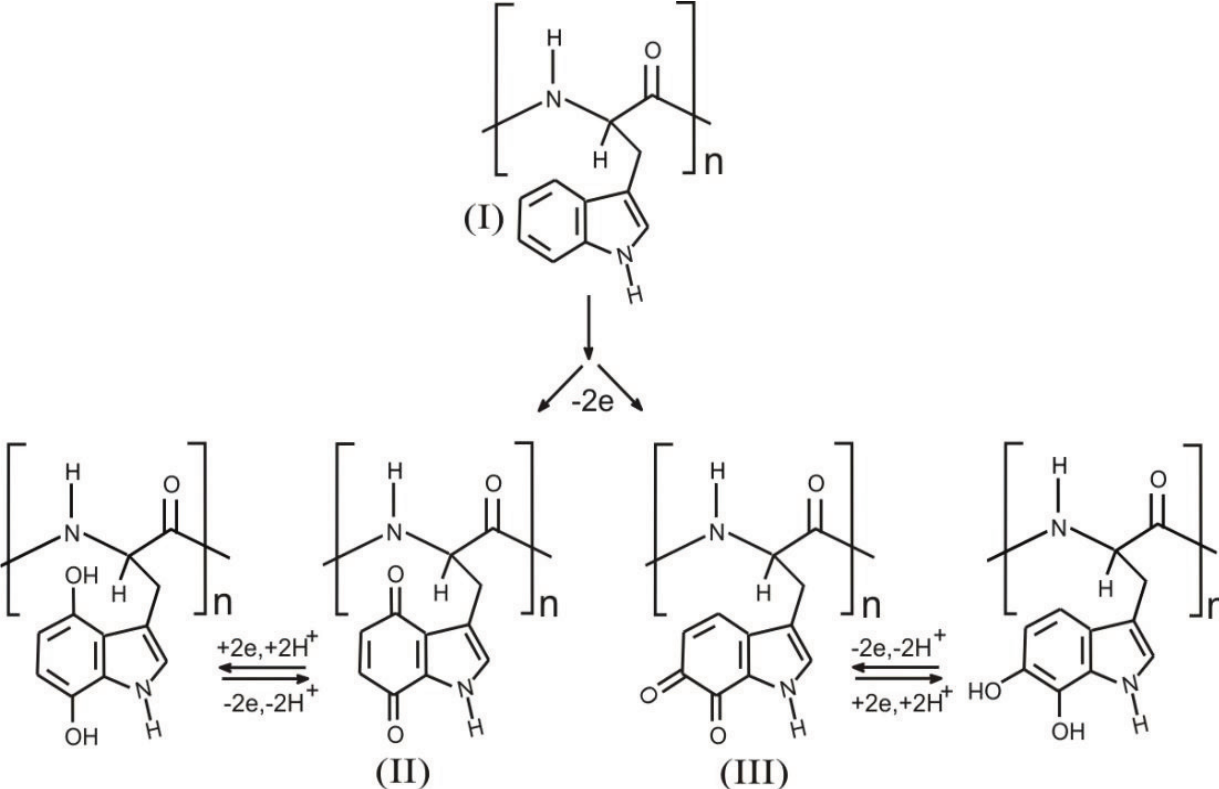
Figure 2. Electrochemical oxidation of polymer bound tryptophan to the corresponding quinone systems and their corresponding hydroquinone redox system.